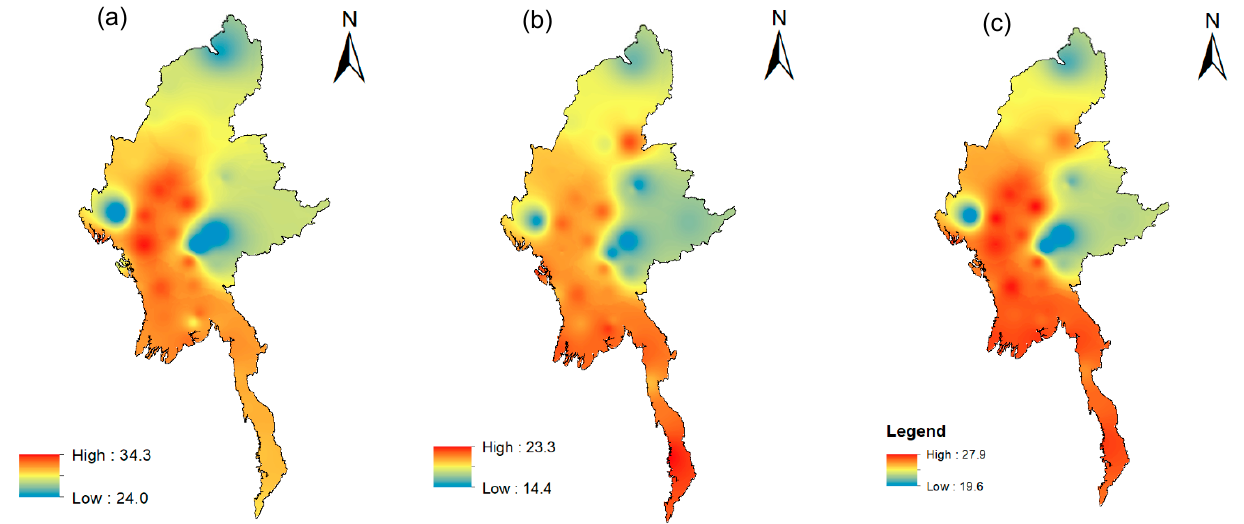
Figure 2. Annual average air temperature in the study area (1971 ‒ 2013). ( a ) Maximum, ( b ) minimum, ( c ) mean.